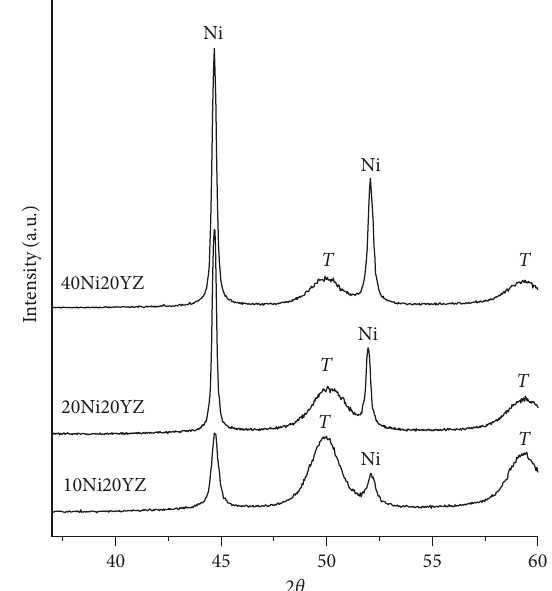
Figure 2: In situ XRD patterns of reduced catalysts. The XRD pattern was collected on the reduced catalyst with H 2 (5% H 2 /He, 50mL · min − 1 ) at a temperature of 800 ° C; the diffraction patterns were identified by comparison with the database of the In- ternational Centre for Diffraction